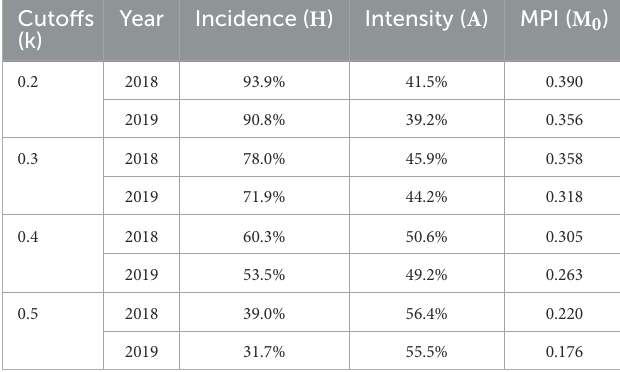
TABLE 2 Incidence ( H ), Intensity ( A ), and MPI ( M 0 ) for different poverty